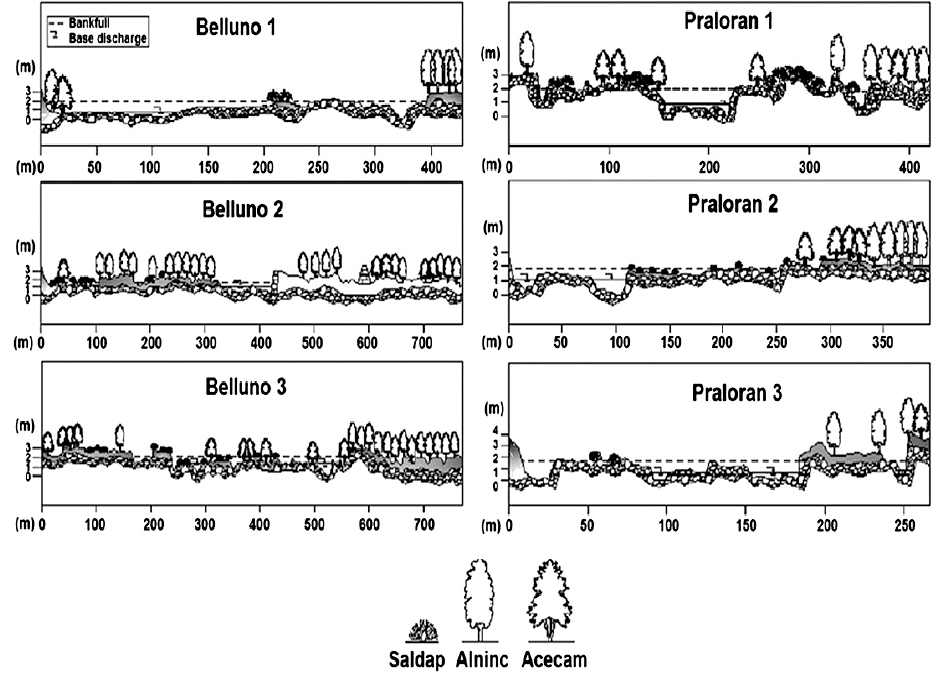
Figure 6. Cross-sections of plant communities in six sub-reaches of the Piave River. The left side of all of the images correspond to the left bank (Alninc: Alnion incanae ; Acecam: Rhamno - Prunetea ; Saldap: Salicion eleagni ). Symbols of trees are not to scale (from [44]).